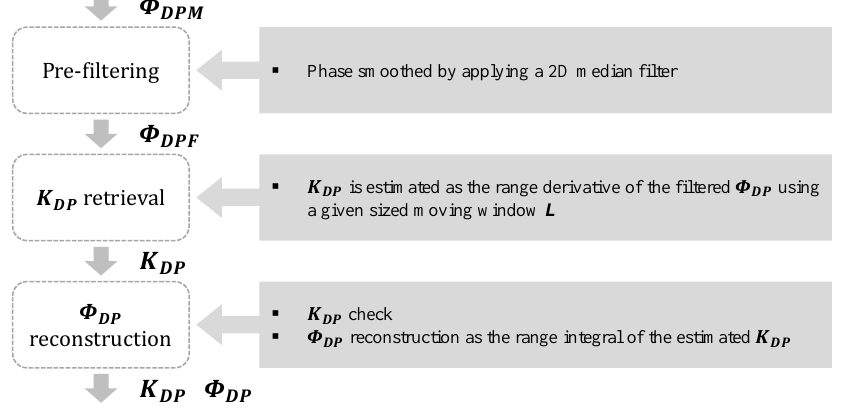
Figure 6. Weather radar data processing